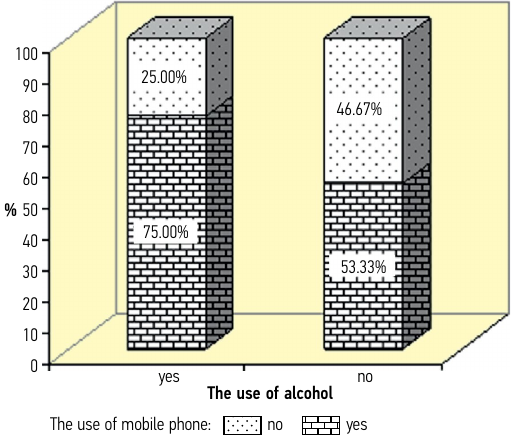
Fig. 4. Hands-free devices usage and traffic accidents